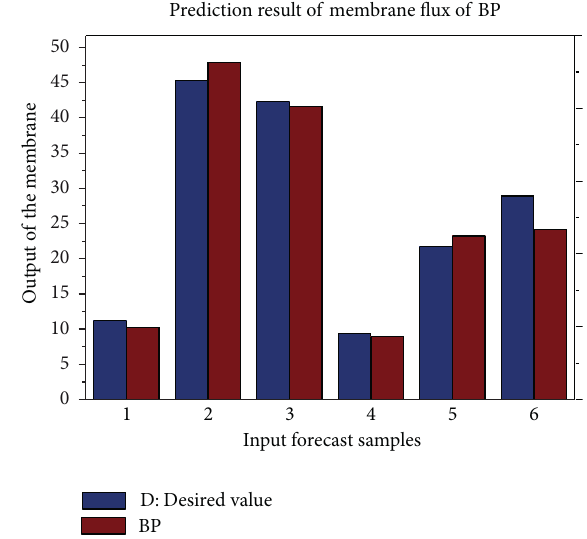
Figure 2: Measured values of membrane flux and predicted values of BP